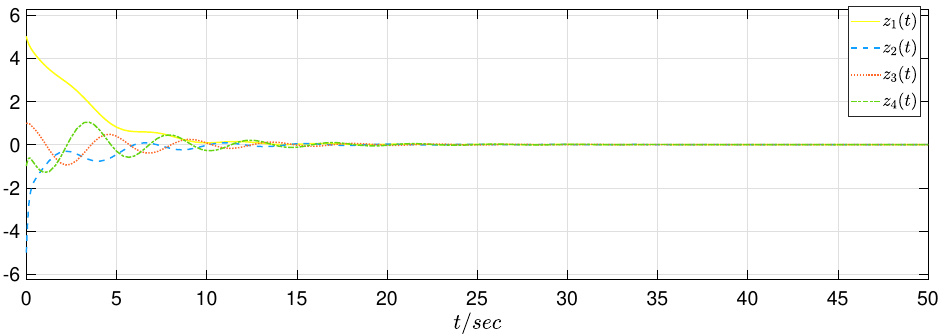
Figure 6. State response of closed-loop system.